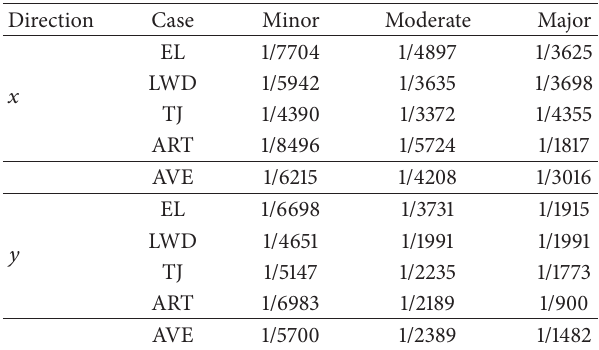
Table 13: Isolation layer torsion angle under different